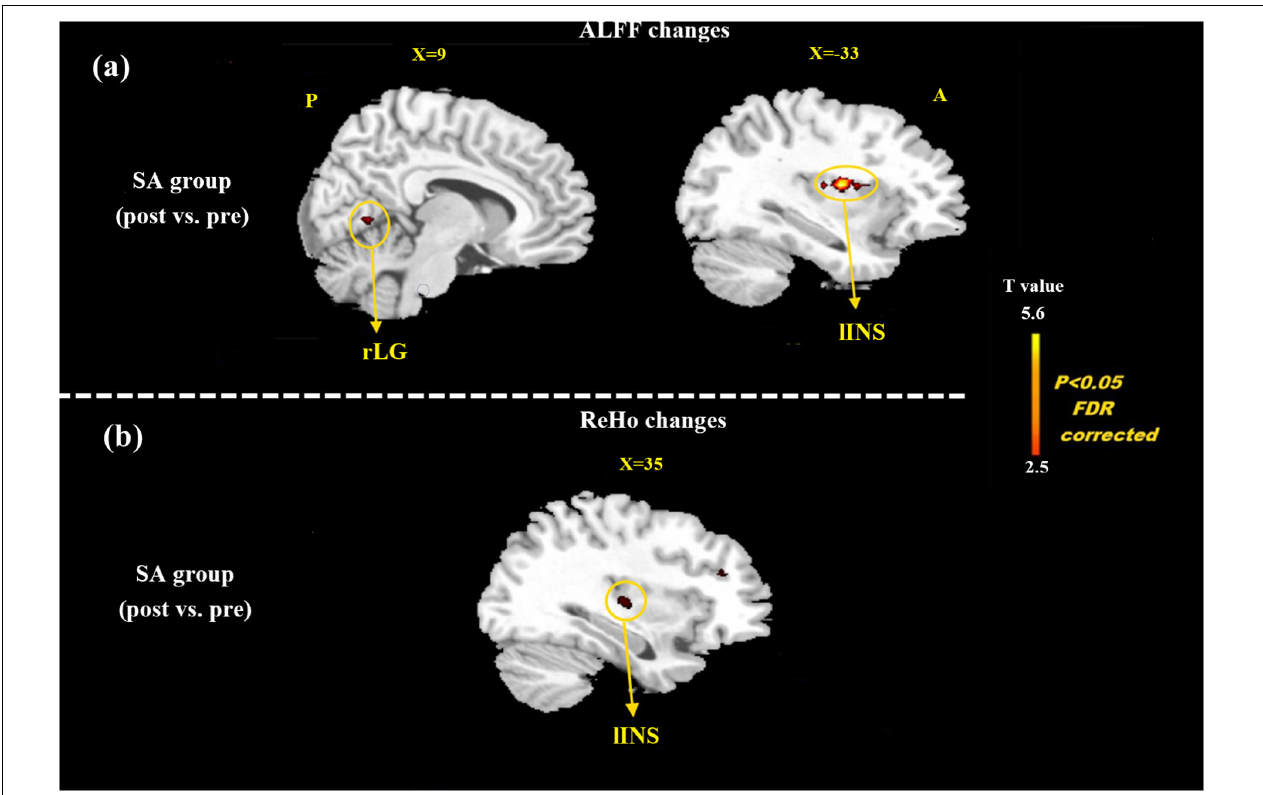
FIGURE 4 | Resting state ALFF and ReHo changes of MMoA patients in sham acupuncture group ( p < 0.05, FDR corrected). (a) Brain regions showed altered ALFF value in MMoA patients after sham acupuncture treatment. (b) Brain regions showed altered ReHo value in MMoA patients after sham acupuncture treatment. Warm colors indicate ALFF and ReHo increases after sham acupuncture group; cool colors indicate ALFF and ReHo decreases after sham acupuncture group. A, anterior; INS, insula; LG, lingual gyrus; P, posterior; SA, sham acupuncture.